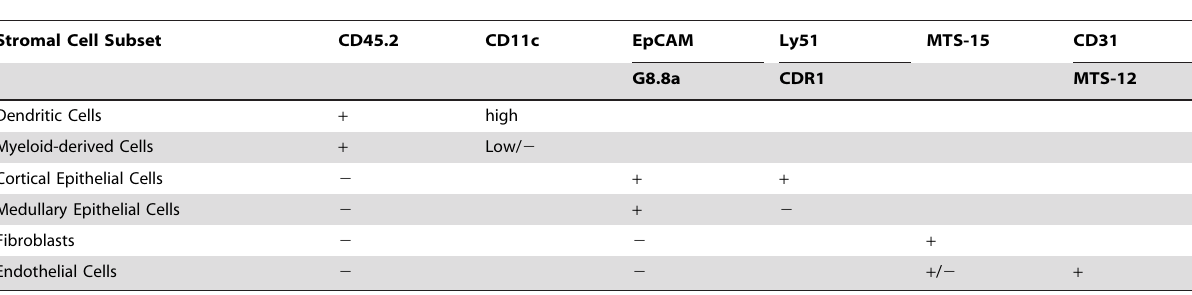
Table 2. Specific cell markers for thymic stromal cell subsets.